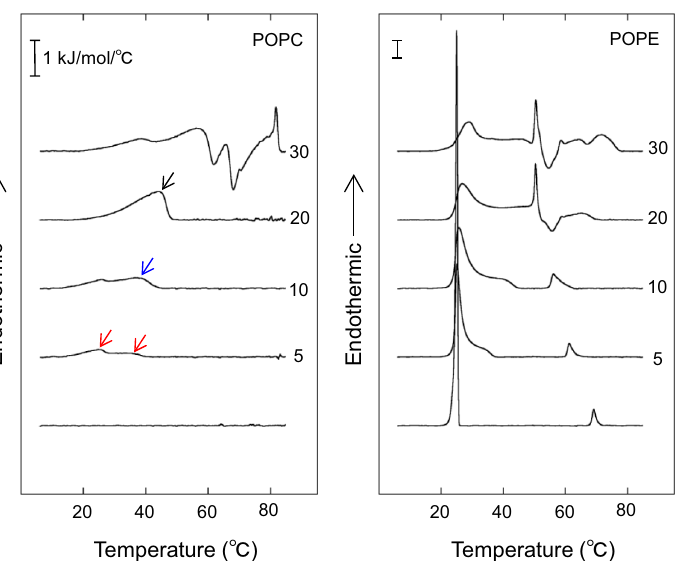
Figure 1. DSC heating thermograms of 1 mM POPC and POPE containing different amounts of C18-ceramide (0–30 mol%). The thermograms were obtained from samples dispersed in 20 mM HEPES buffer (pH 7.0) containing 100 mM NaCl and 10 mM EDTA, and were recorded at scan rate of